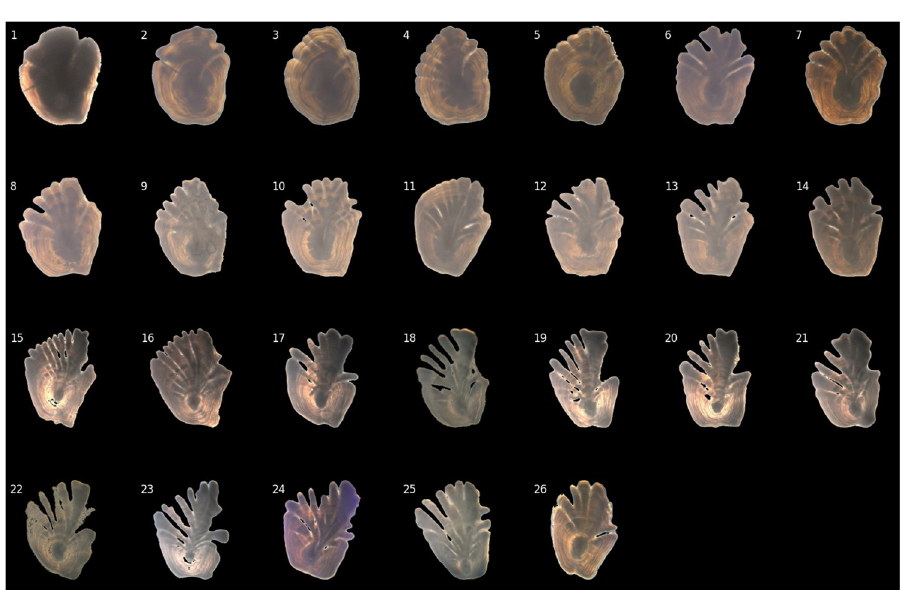
Fig 2. Selection of Greenland halibut otoliths. The figure shows a selection of Greenland halibut otoliths for each age in the range of 1 to 26 years. The images are standardized to have the same maximum vertical extension. The most evident growth pattern is the development of fingers and holes in the otolith as the fish grows older. The annual zones are not visible in all images. We see, however, that the dark initial core with a diameter of roughly 2 mm, has a relative location that gets lower with age, i.e., the upper part of the otolith grows faster with age than the lower